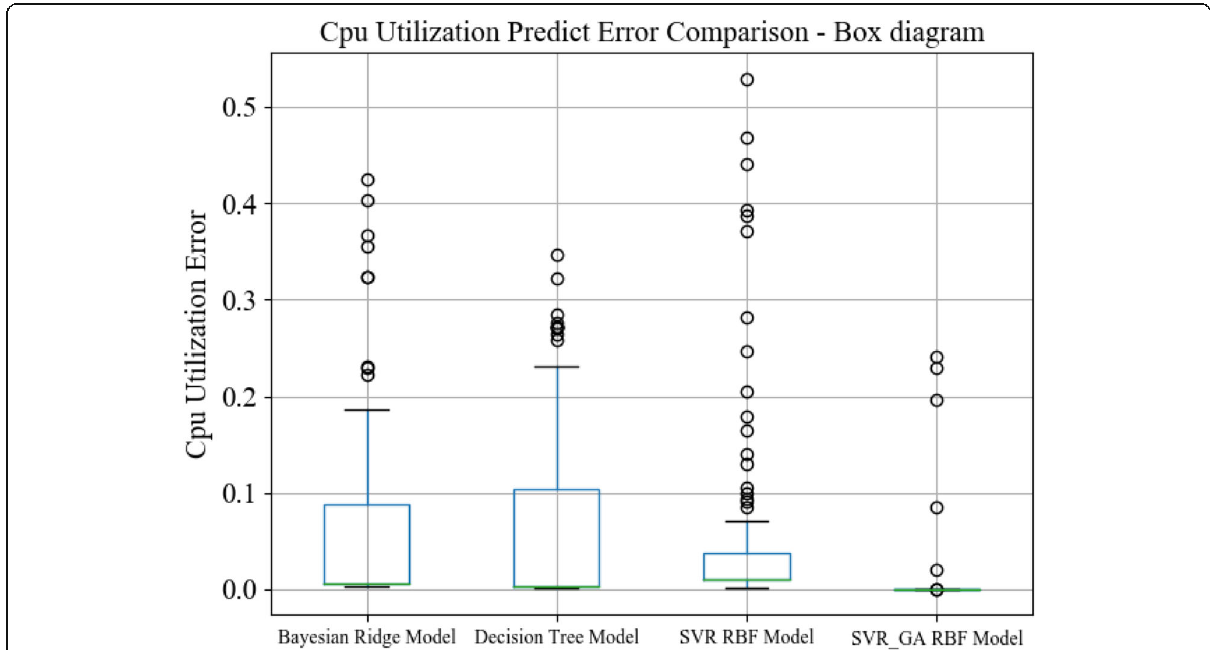
Fig. 4 Comparison of server load prediction errors-box